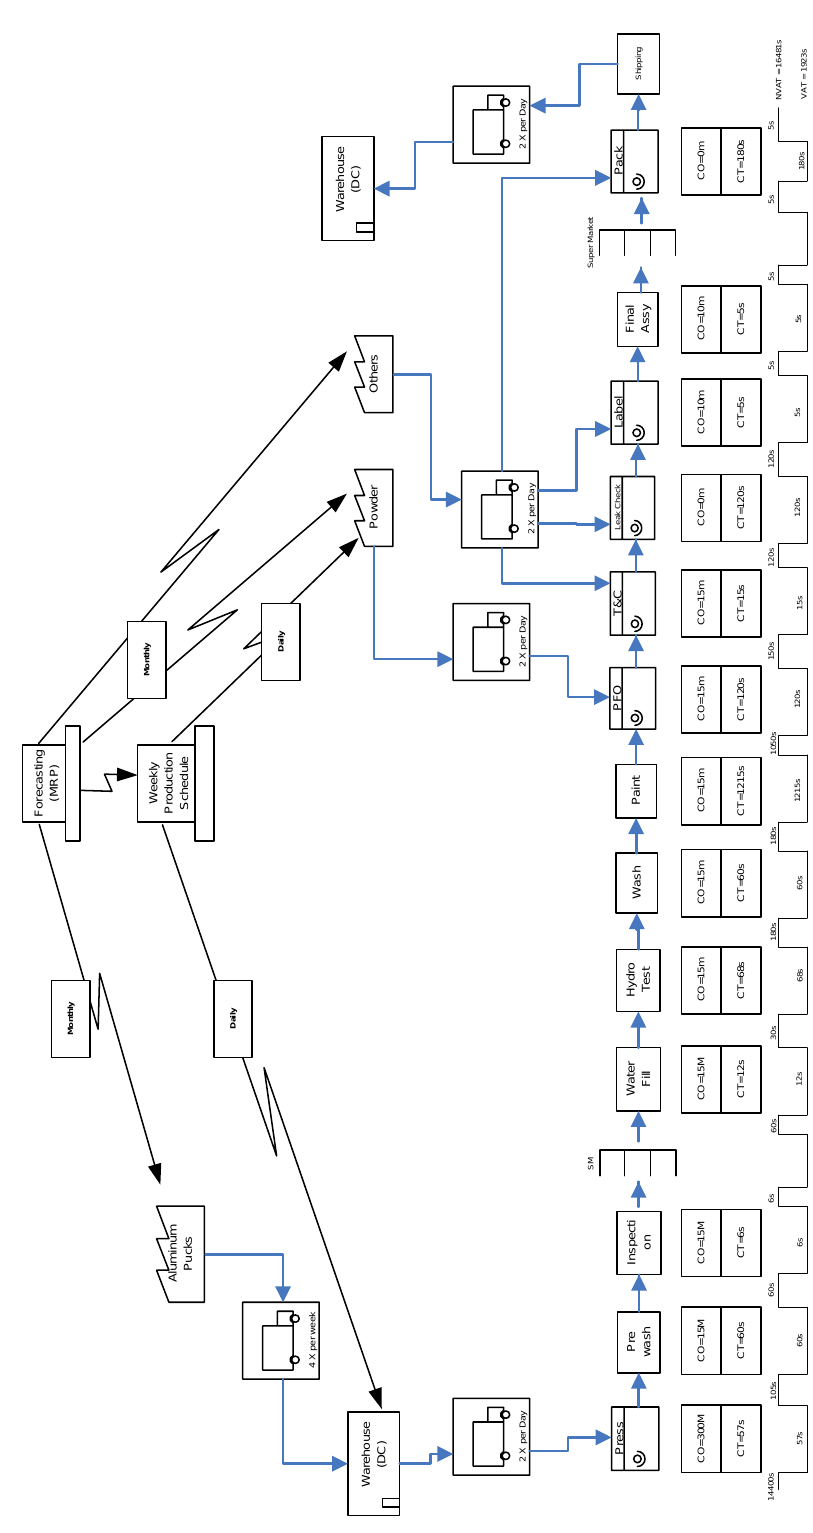
Figure 2. “HOP-VSM - future state map”. Source: